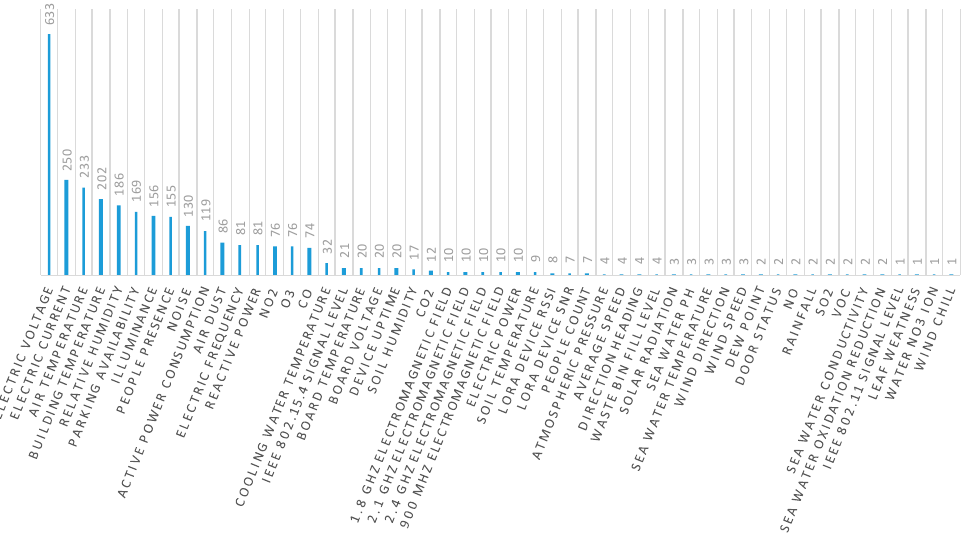
Figure 5. Amount of active sensors per phenomenon.